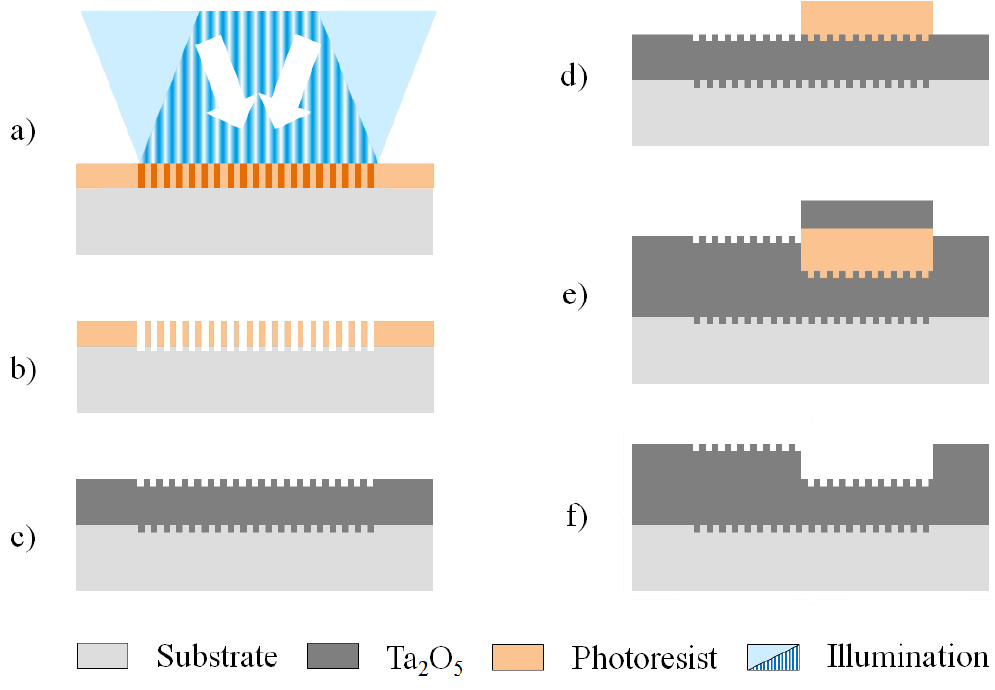
Figure 3. Chip production sequence: ( a ) exposure of the deposited photoresist to interference lithography; ( b ) photoresist development and subsequent etching of the substrate by reactive ion etching (RIE); ( c ) O 2 plasma stripping of the photoresist and sputtering of a first Ta 2 O 5 layer; ( d ) deposition and structuring of a sacrificial photoresist; ( e ) sputtering of a second Ta 2 O 5 layer and ( f ) lift-off of the additional Ta 2 O 5 by removing the sacrificial